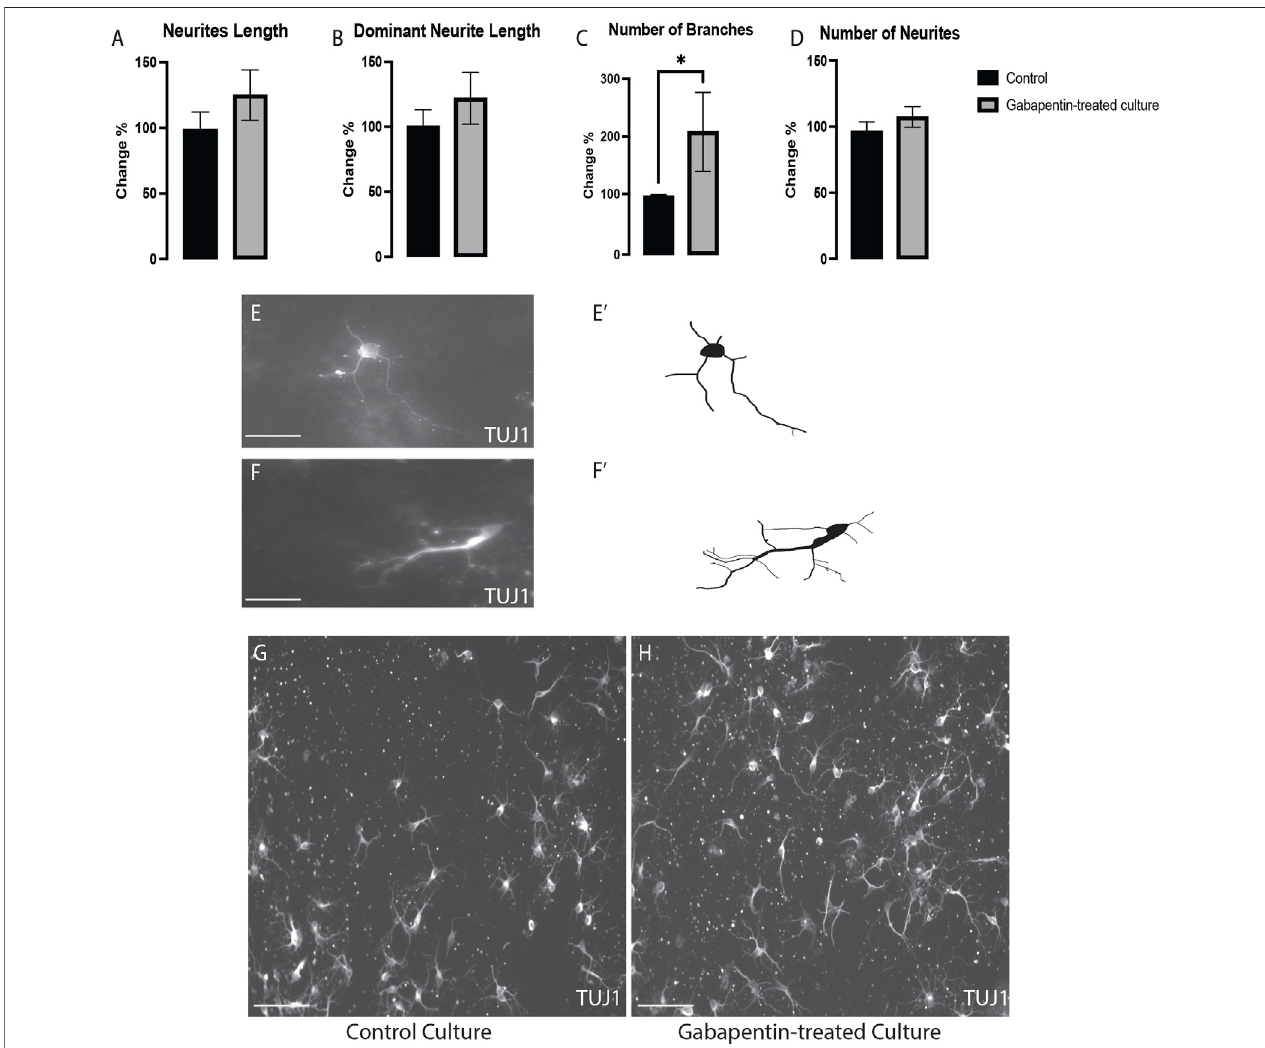
FIGURE 4 | VM nondopaminergic neurons (TUJ1+/TH-) subjected to gabapentin exposure having no changes in the total neurite length (A) , the dominant neurite length (B) or the number of neurites (D) , while having signi fi cant increases in the number of branches (C) . Representative images and illustration for VM neurons immunolabeled with TUJ1 in both groups; control (E,E ’ ) and gabapentin-treated (F,F ’ ) show the increase in the numbers of branches in response to gabapentin exposure. (G,H) images show large fi eld of view (20x) for both groups; control and gabapentin treated cultures, respectively. Scale bar = 50 um (E,F) . Scale bar = 10 um (G,H) . Data are represented as mean ± SEM, n = 4 experiments. * p < 0.05.